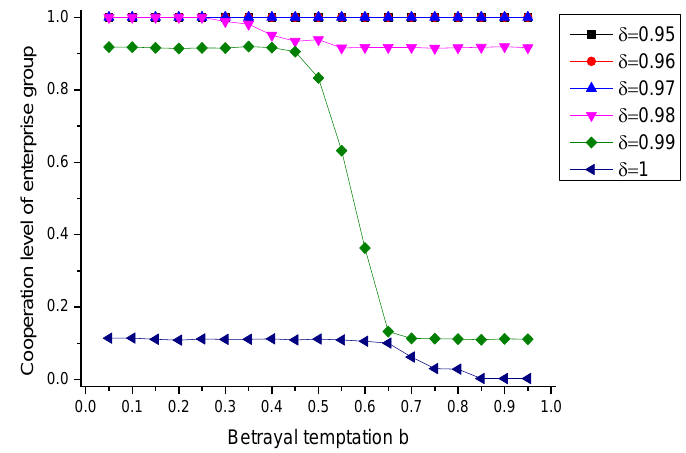
Figure 3. The evolutionary equilibrium under different environmental preference.